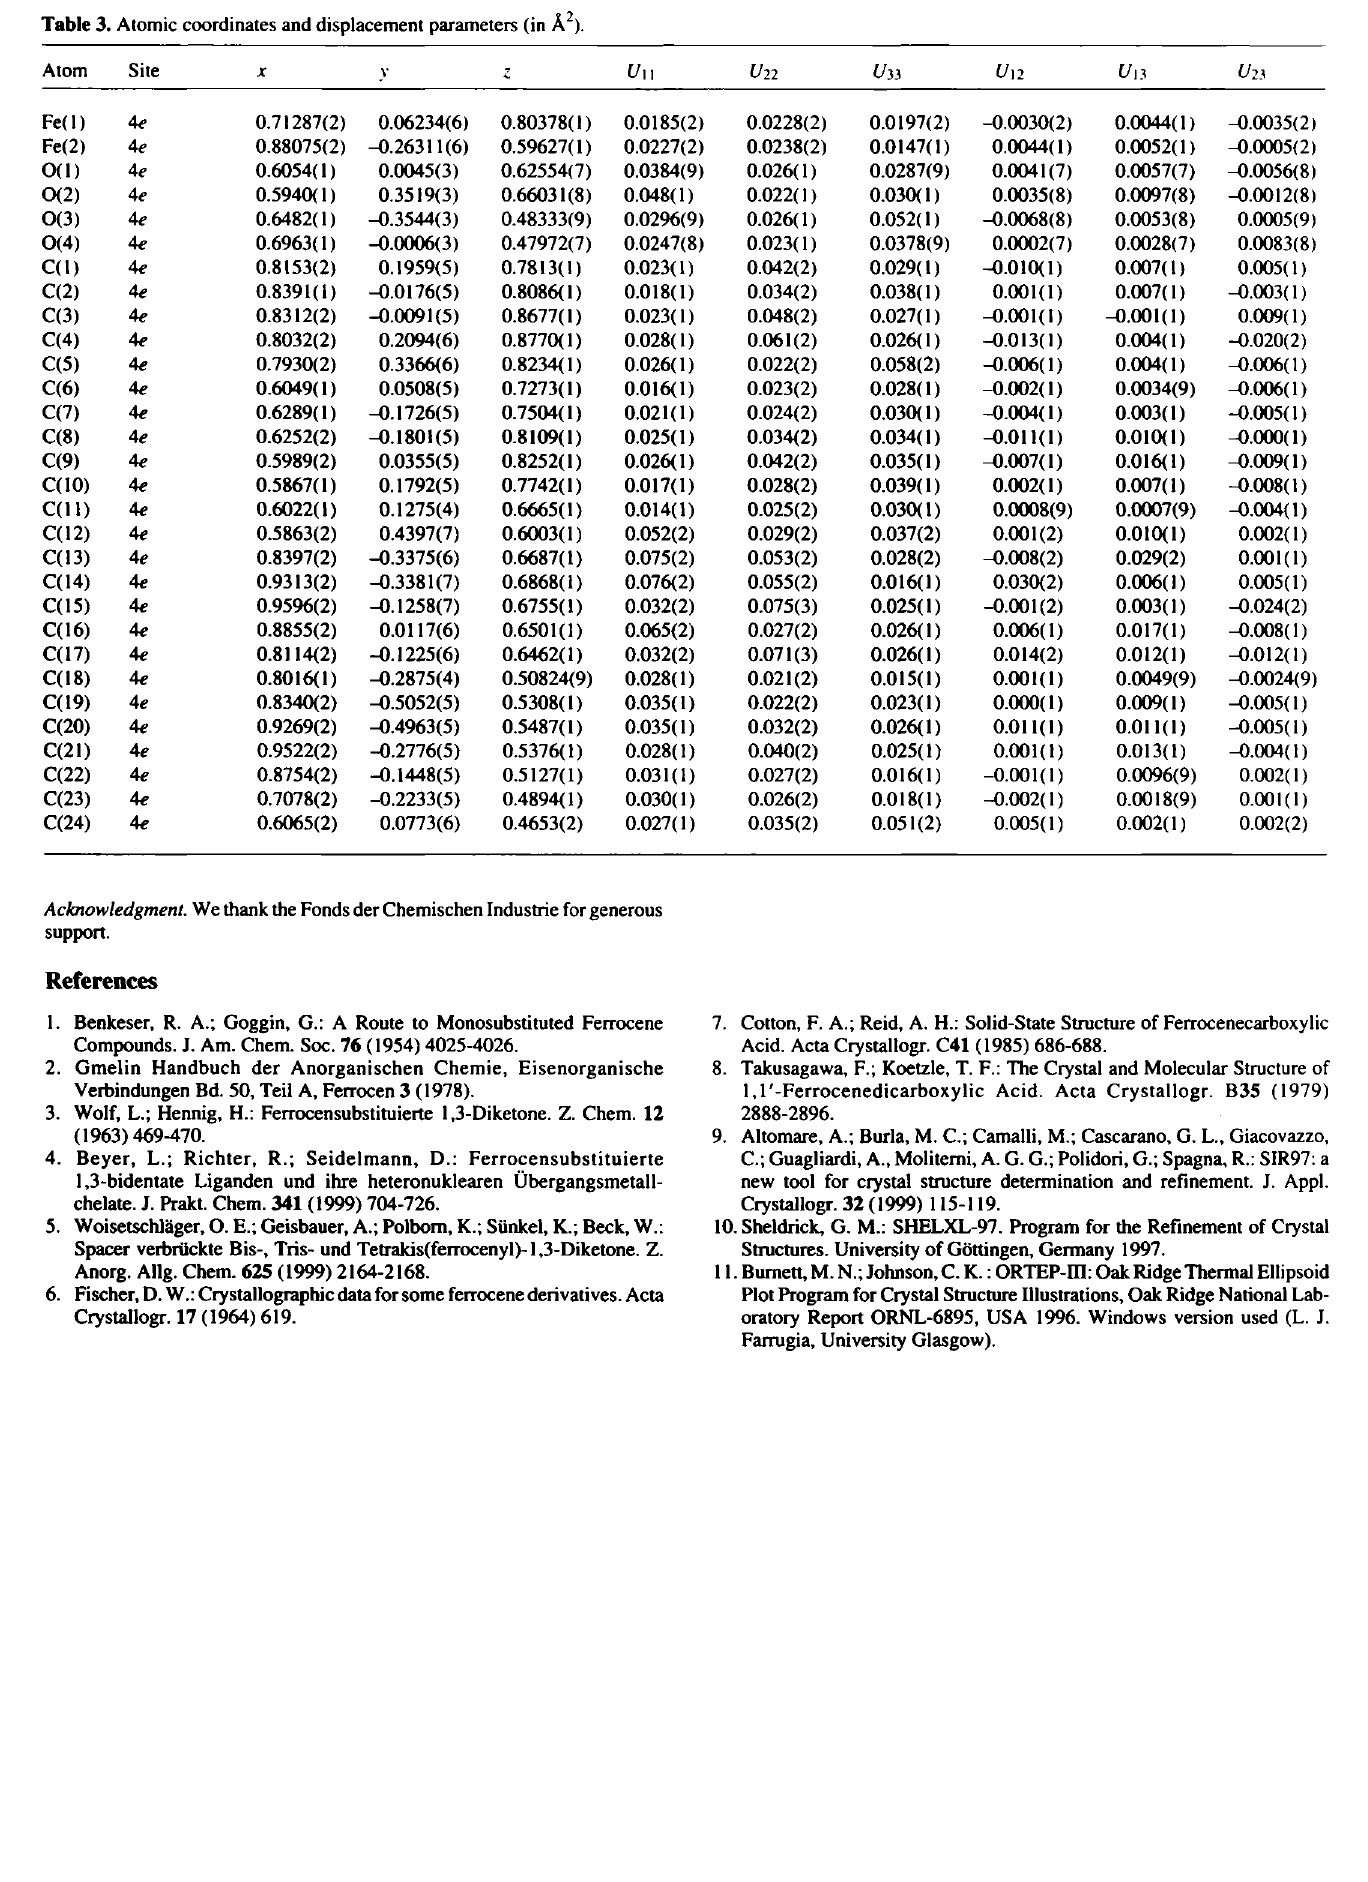
Table 3. Atomic coordinates and displacement parameters (in Ä 2